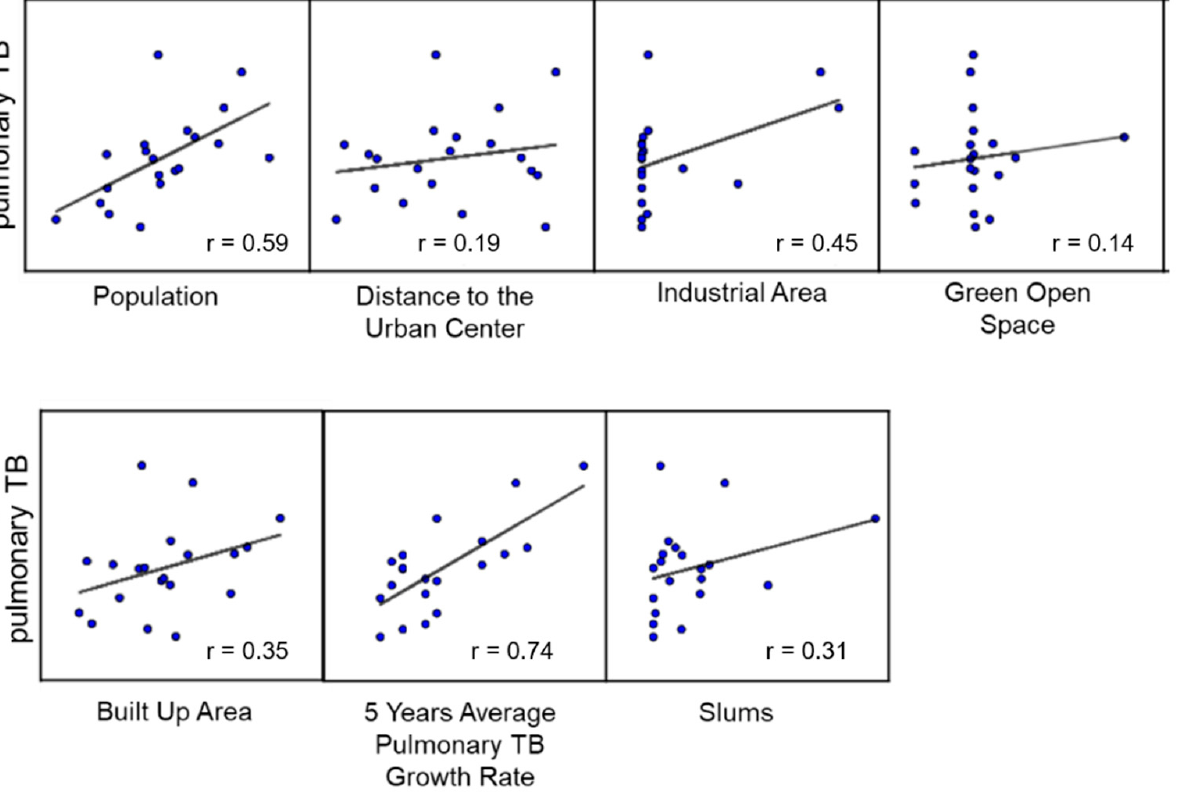
Table 2. Statistical summary of ordinary least square (OLS) results.